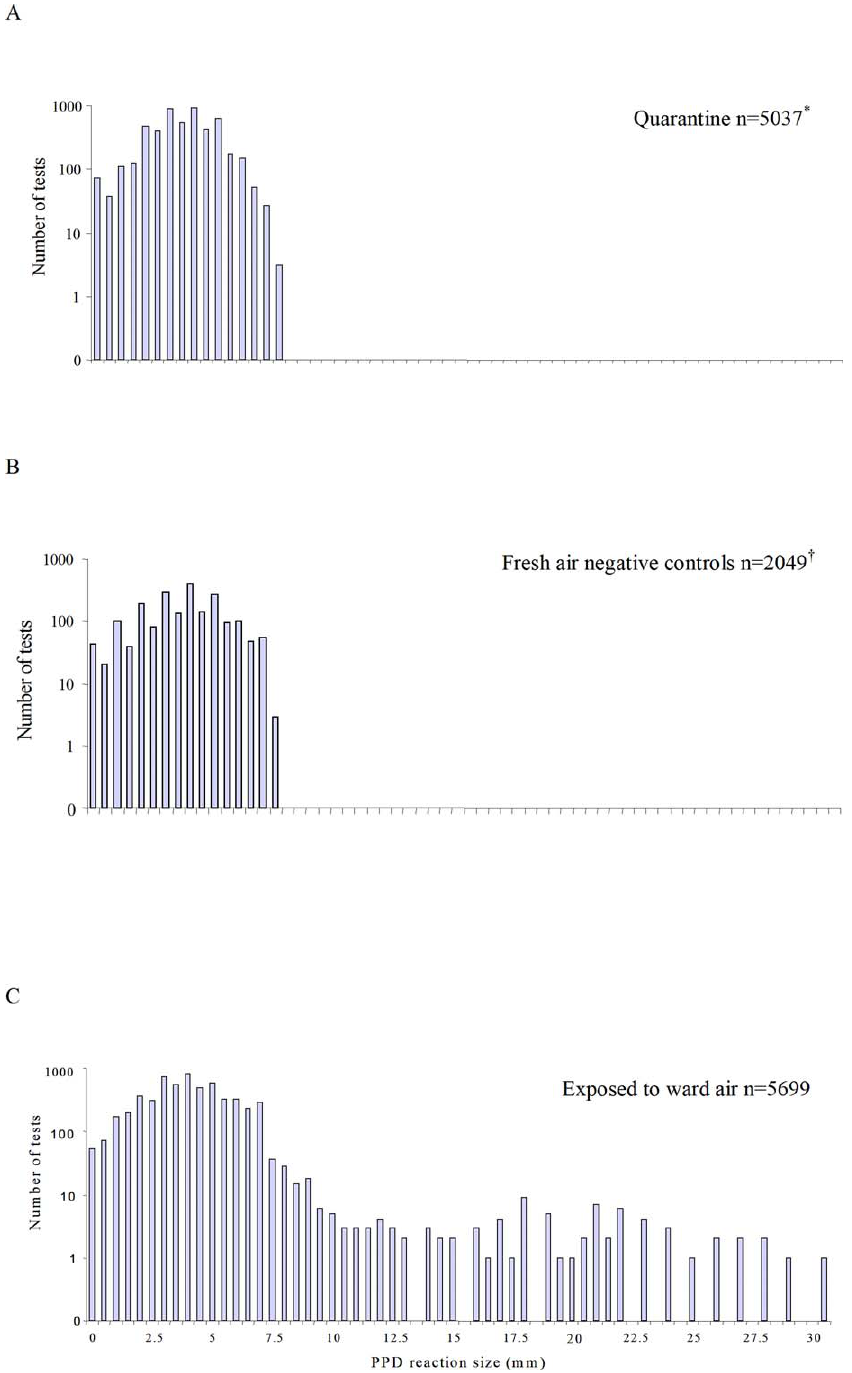
Figure 3. Guinea Pig PPD Skin Test Responses The frequency distributions of guinea pig PPD skin test responses are shown for (A) quarantined animals, (B) roof air negative controls, and (C) ward-air exposed guinea pigs. The frequencies of the PPD responses have been plotted using a logarithmic scale on the y -axis to demonstrate the distribution of positive ( (cid:3) 7.5 mm) responses seen in the exposed group of animals. Zero frequencies are plotted on the logarithmic scale as zero. PPD responses were measured to the nearest 0.5 mm; therefore, each bar represents the frequency of a single measurement value. *In 5,037 tests in 624 animals over 11 mo, there were three false positive PPD skin test results in quarantine animals. All were 7.5 mm and reverted to , 7.5 mm in subsequent months. (cid:2) In 2,049 tests in fresh-air negative controls, there was one false positive result (7.5 mm).